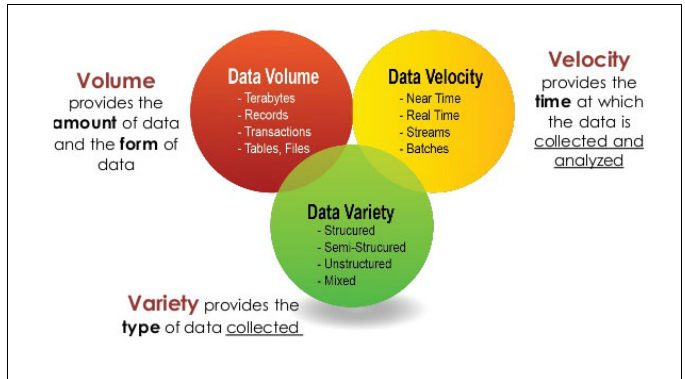
Fig. 1. The characteristic of Big Data Analytics